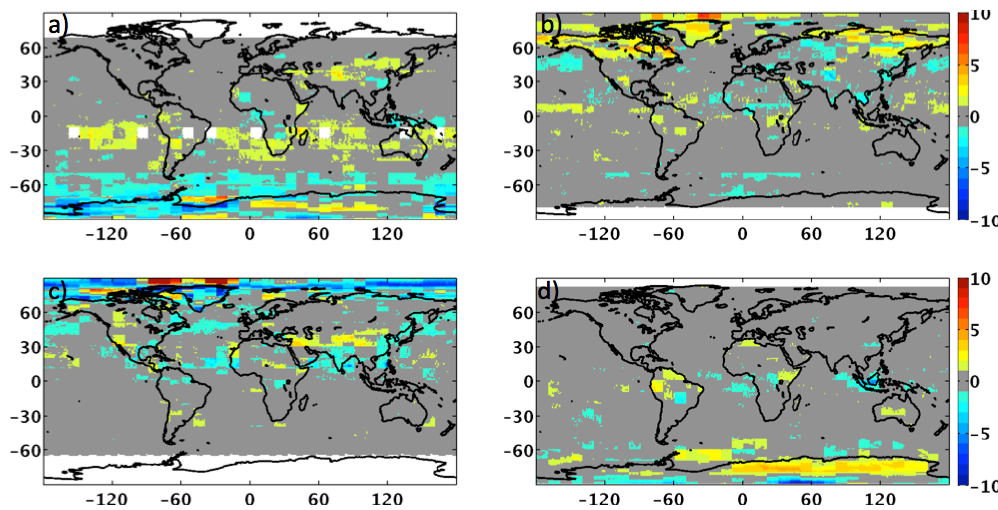
Figure 1. Monthly regional mean TOA shortwave flux error from ADM uncertainties for (a) January, (b) April, (c) July, and (d) October 2002 using Terra measurements.